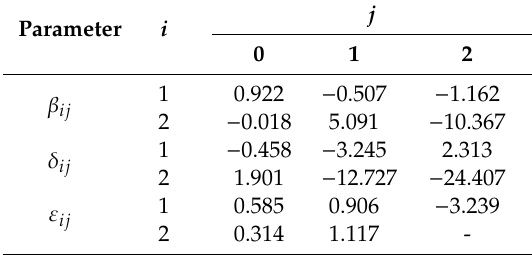
Table 8. Non-dimensional parameters for calculating the Fujiwara